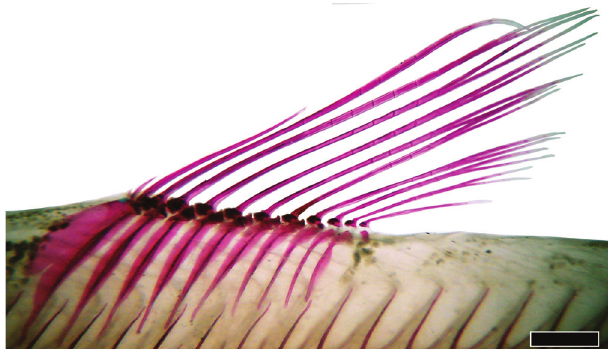
Fig. 2. Left lateral view of the dorsal fin of Moenkhausia dasalmas , paratype, UFRGS 11194, 23.3 mm SL, c&s; showing the unbranched and branched rays. Scale bar = 1 mm.